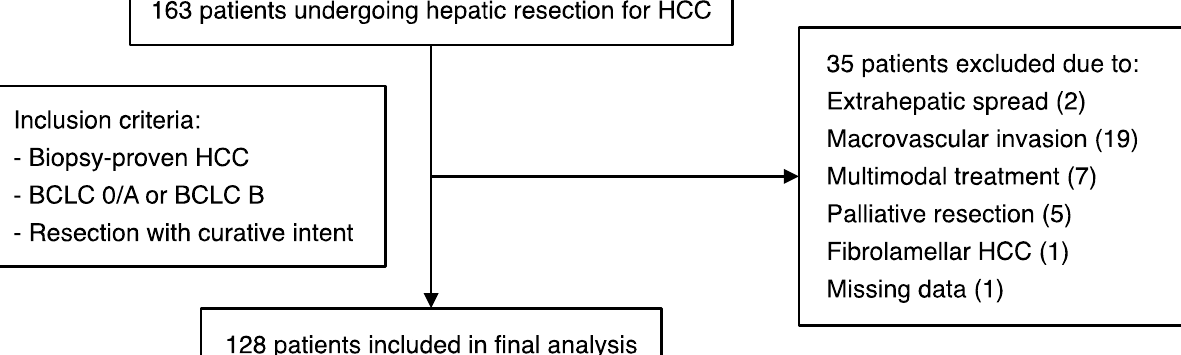
Figure 1. Schematic representation of the patient cohort, with details of the inclusion/exclusion criteria applied for this study.